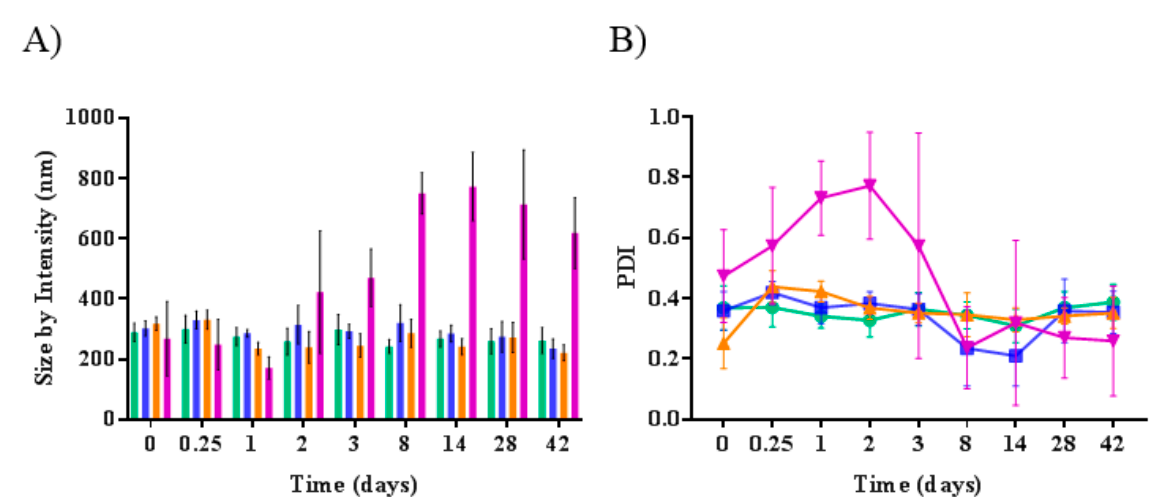
Figure 4. Size ( A ) and poly dispersity index (PDI) ( B ) of pullulan-dexamethasone particles after different exposure times in buffer solution at 4 °C ( ■ ), 25 °C ( ■ ), 37 °C ( ■ ) and in homogenized vitreous at 37 °C ( ■ ).